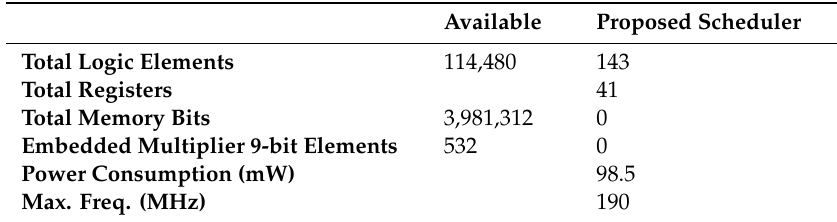
Table 3. Place and Route Results.